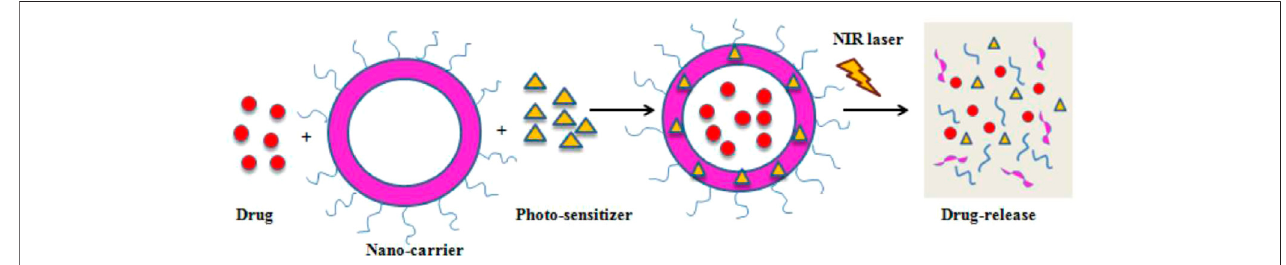
FIGURE 4 | A schematic illustration of PDT-mediated drug release. Reprinted (adapted) with permission from Rai et al. (2021). Medicina (Kaunas). 2021,57 (2),91. Copyright 2021 by the authors.